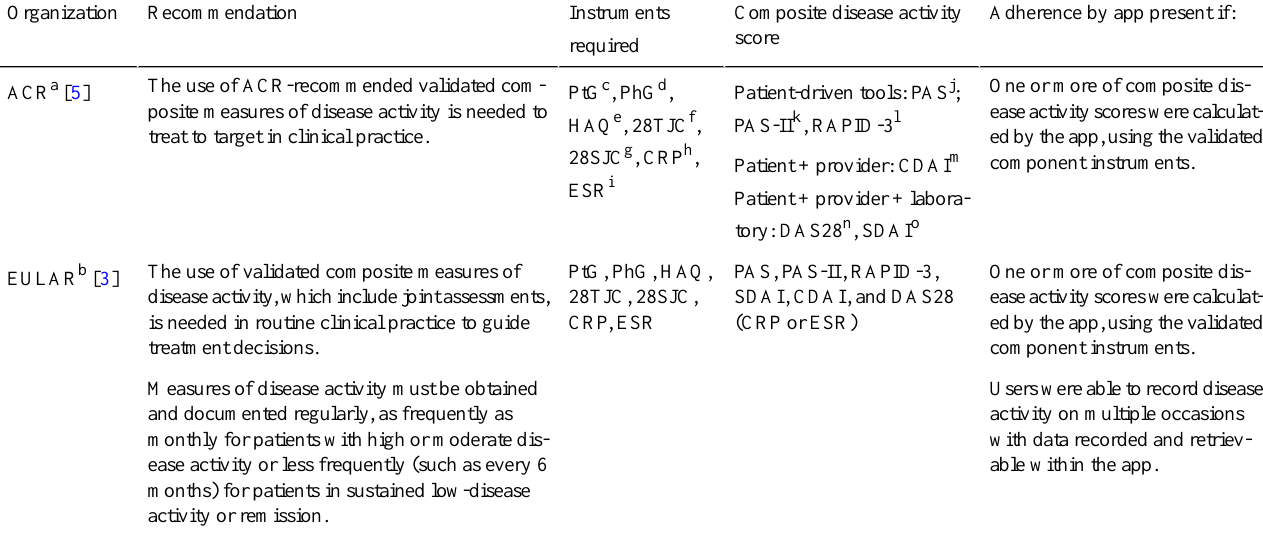
Table 1. Recommendations from the American College of Rheumatology (ACR) and the European League Against Rheumatism (EULAR) for rheumatoid arthritis (RA) disease activity